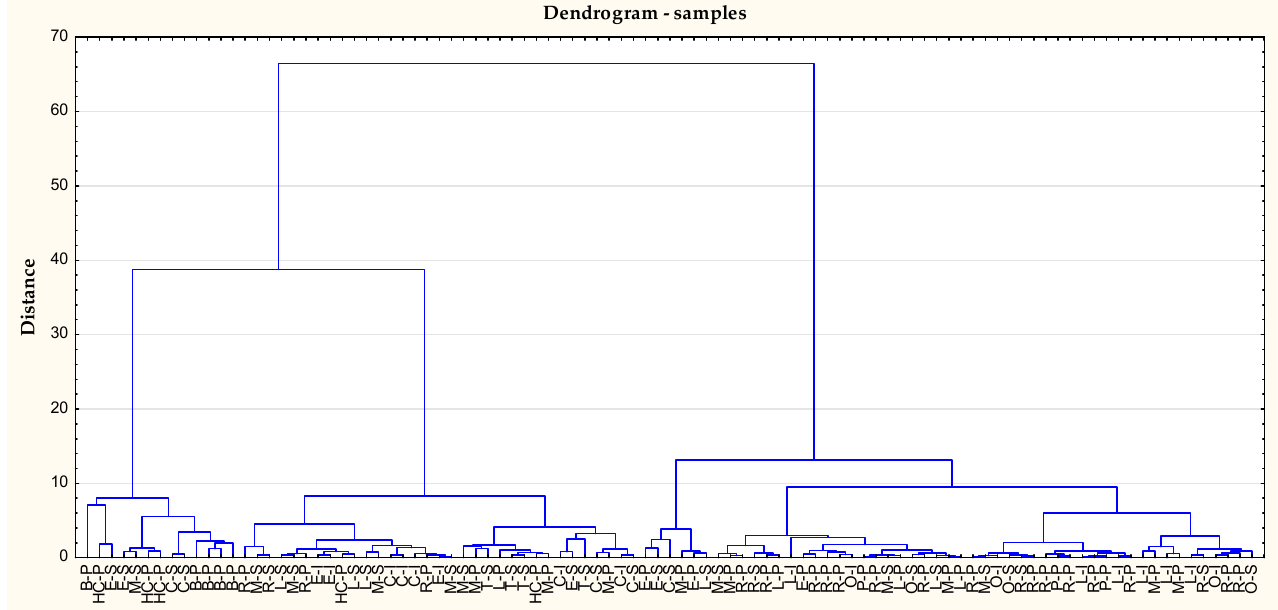
Figure 1. Dendrogram for the studied cases. B-P—buckwheat-Poland, C-I—chestnut-Italy, C-S— chestnut-Spain, E-I—eucalyptus-Italy, E-P— Ericace -Poland, E-S— Erica- Spain, HC-P—honeydew-